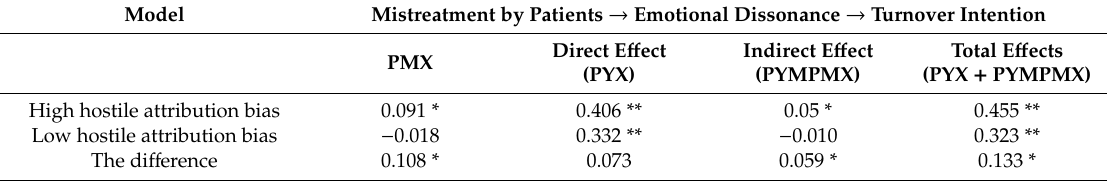
Table 5. Direct, indirect, and total e ff ects at di ff erent levels of hostile attribution